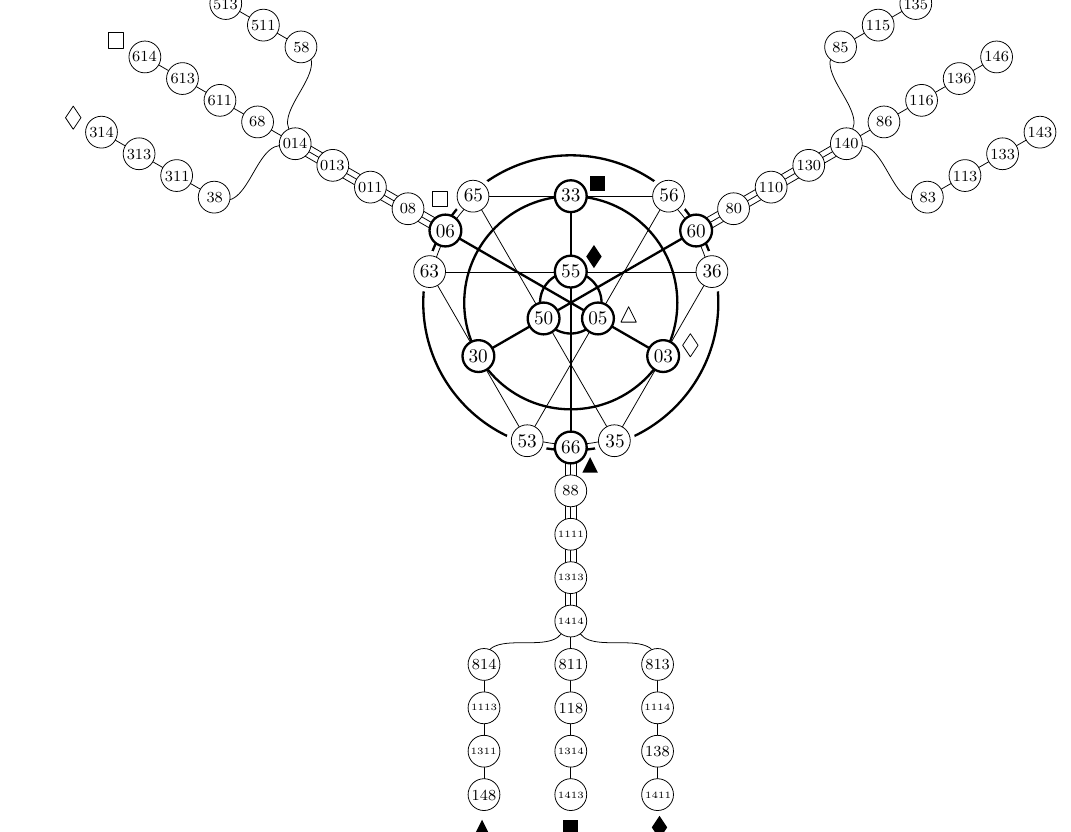
Figure 3. Visualisation of the full geometric structure formed by the nine nonunimodular free cyclic submodules, with the doily lying in its center. For each submodule there are shown all of its vectors except for the trivial one. For six submodules pairs of identical symbols are employed to identify the corresponding points of concurrence; the remaining three cases are obtained by swapping the figure with respect to the vertical axis passing through the center. The distinguished GQ(2,1) of the doily is shown in